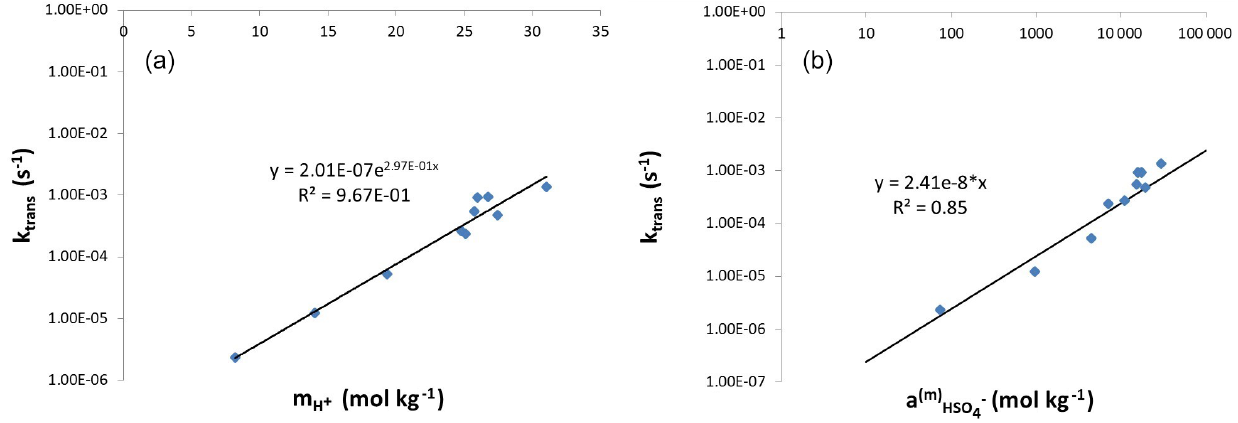
, the activity of ion HSO − 4